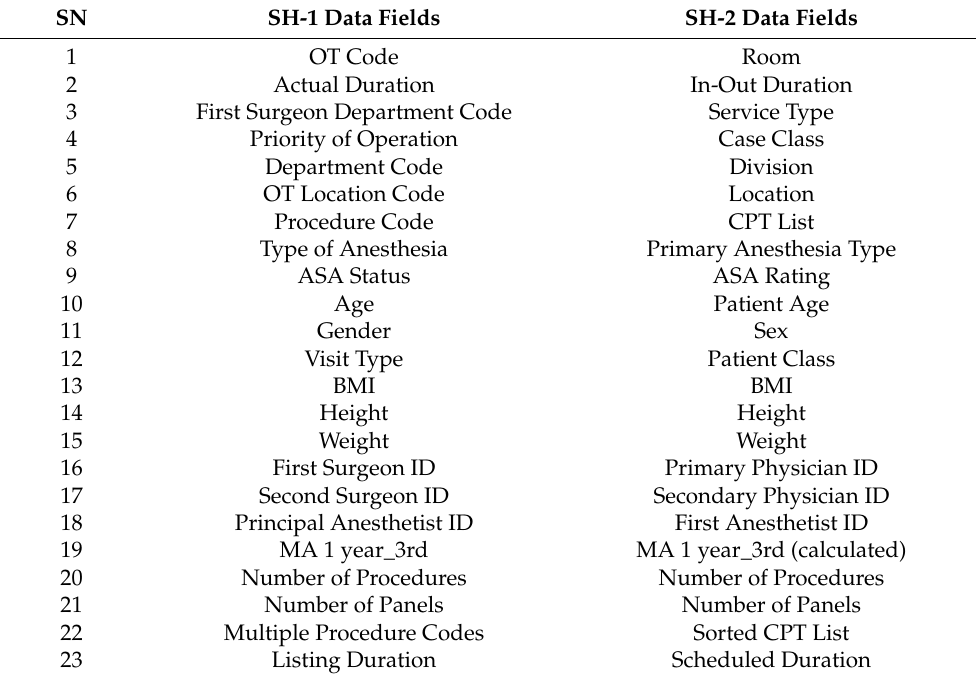
Table 1. Field mapping between SH-1 and SH-2.